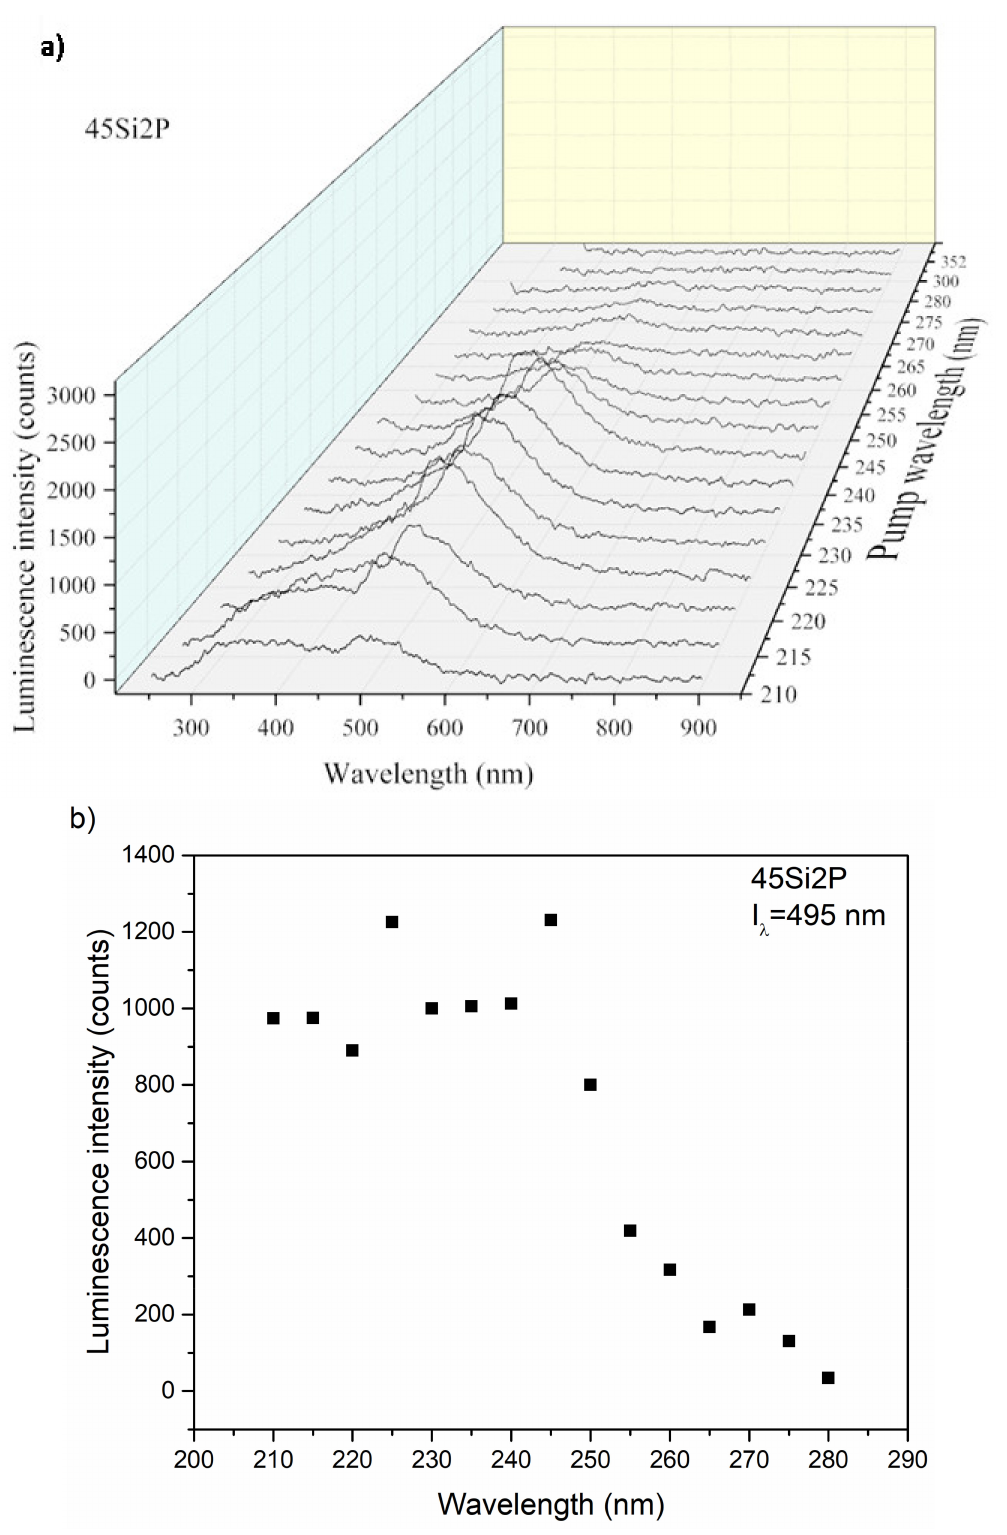
Figure 18. Luminescence intensity vs. wavelength and the laser pump ( a ) and luminescence intensity vs. wavelength at 500 nm ( b ) for the 45Si2P